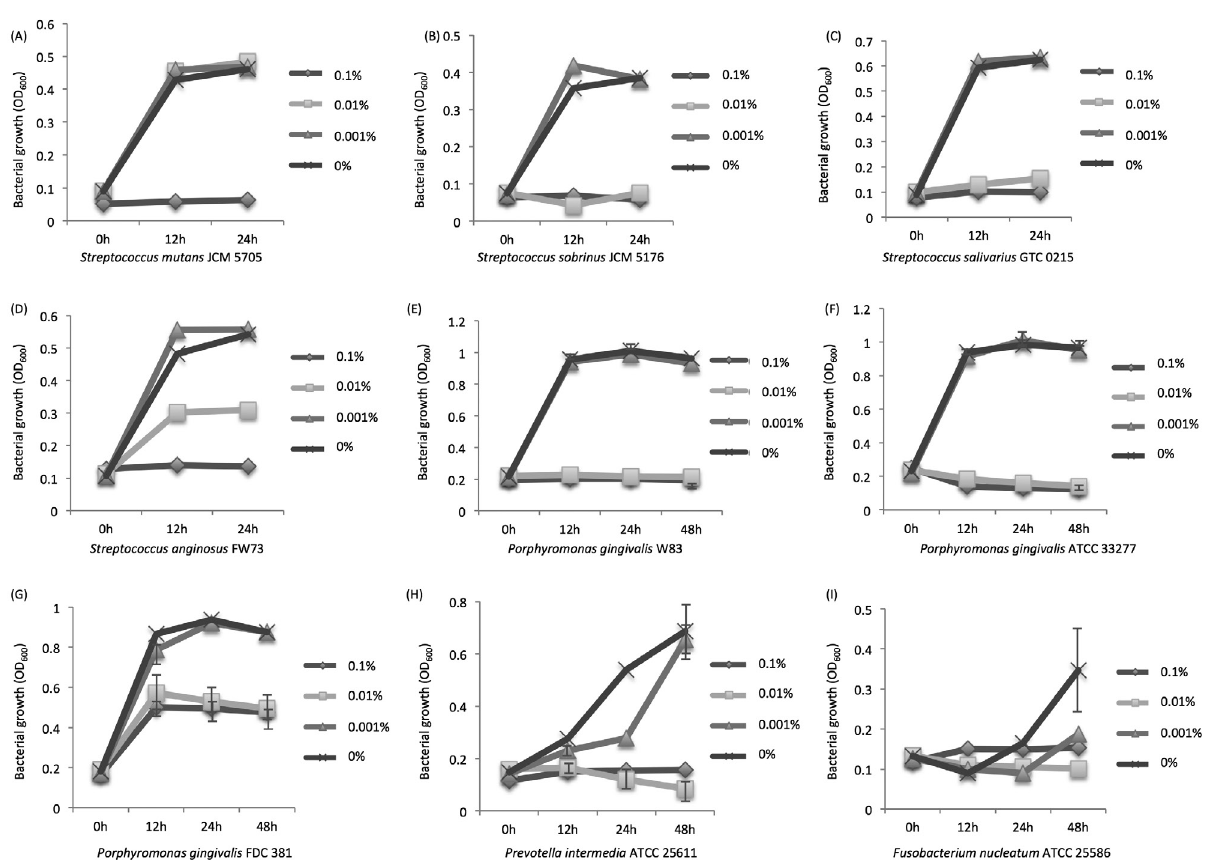
Figure 3- Inhibitory effects of zinc ions on the growth of oral bacteria (mean ± SD). Streptococcus mutans JCM5705 (A), Streptococcus sobrinus (B), Streptococcus salivarius GTC0215 (C), Streptococcus anginosus FW73 (D), Porphyromonas gingivalis W83 (E), ATCC 33277 (F), FDC 381 (G), Prevotella intermedia ATCC 25611 (H), and Fusobacterium nucleatum ATCC 25586